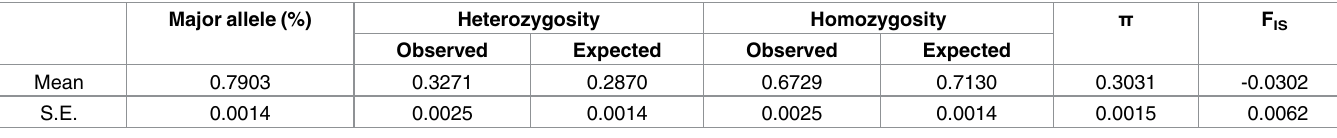
Table 2. Overview of genetic diversity in this population of 11 hog deer. Major allele